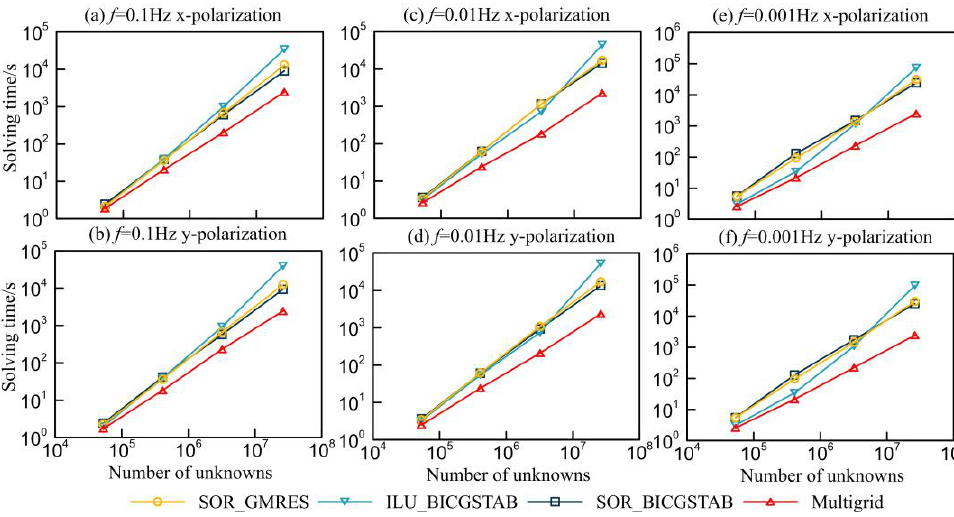
Figure 17. Comparison of computational time for SOR-GMRES, ILU-BICGSTAB, SOR-BICGSTAB and our MG algorithm for the modified SEG/EAEG salt dome model in x , y -polarization modes at 0.1, 0.01 and 0.001 Hz. The residual threshold is 10 −7 . The computation is conducted on the grid size of 32 × 32 × 16, 64 × 64 × 32, 128 × 128 × 64, 256 × 256 × 132, with the number of unknowns being 53,328, 409,760, 3,211,584, 26,219,140, respectively.